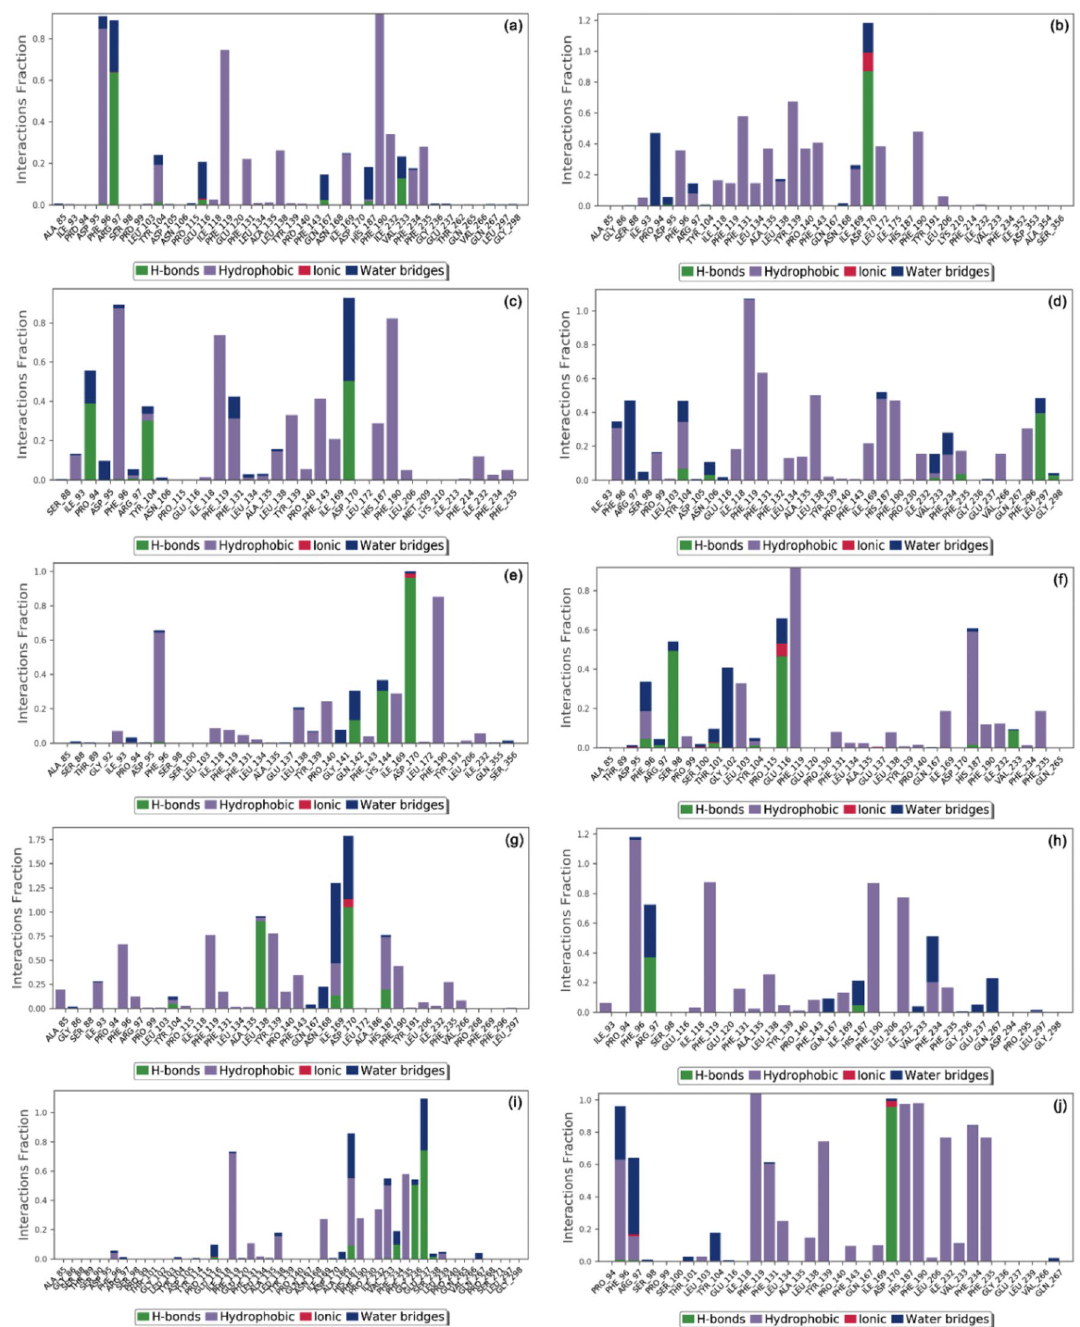
Figure 7. Protein–ligand interaction mapping for Sirt2 docked with selected FDA-approved drugs, i.e., ( a ) Canagliflozin, ( b ) Flibanserin, ( c ) Ezetimibe, ( d ) Pimozide, ( e ) Fluphenazine, ( f ) Droperidol, ( g ) Osimertinib, ( h ) Pioglitazone, ( i ) Formoterol, and ( j ) Nintedanib, extracted from respective 100 ns MD